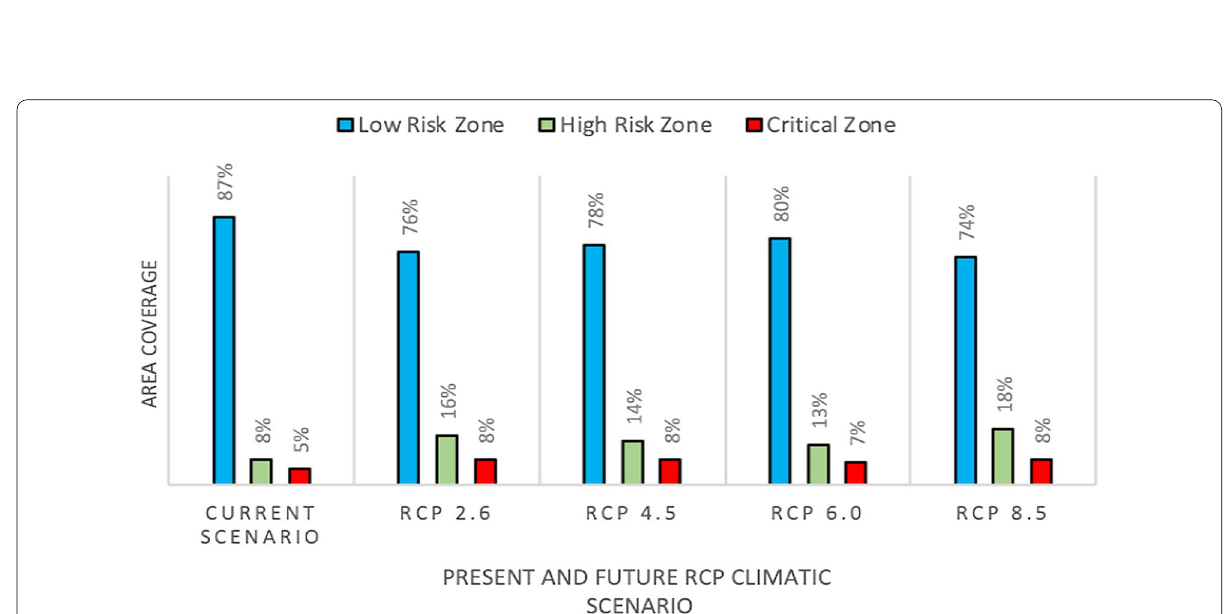
Fig. 6 Variation in a projected suitable area for distribution of L. camara spread for present and future climatic scenarios under different RCPs (AUC value > 0.49: Low, 0.5–0.7: High, > 0.7: Critical). The chart demonstrates probable increase in potential distribution area of L. camara in the range of 20–26% from the current ~ 13% with maximum probable increase upto ~ 26% under the RCP 8.5 by